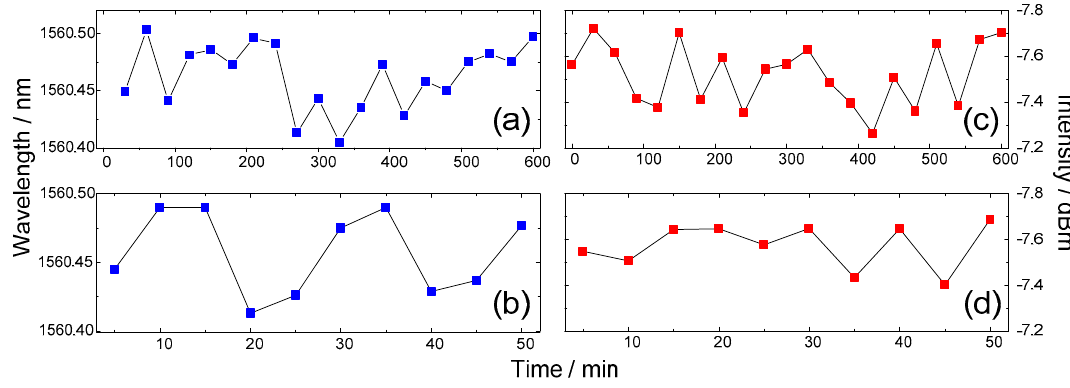
Figure 10. Wavelength shifts in ( a ) long term, ( b ) short term, and mean power fluctuations in ( c ) long term, ( d ) short term under electrical feedback controlling.